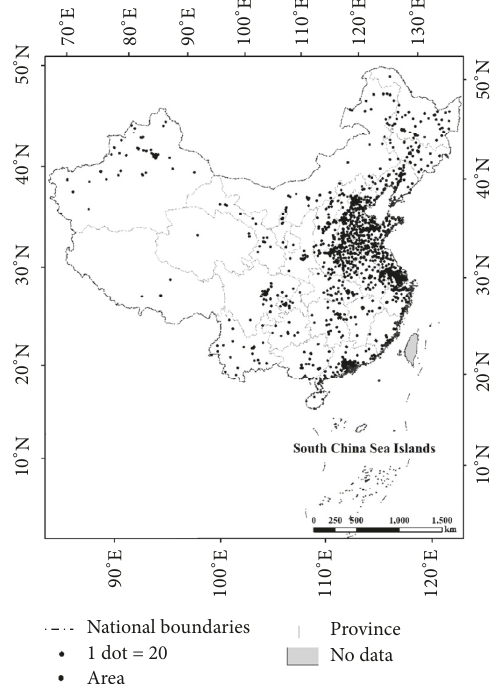
Figure 3: Spatial distribution of built-up area in 2014 in China. One dot represents 20 km 2 (unit: km 2